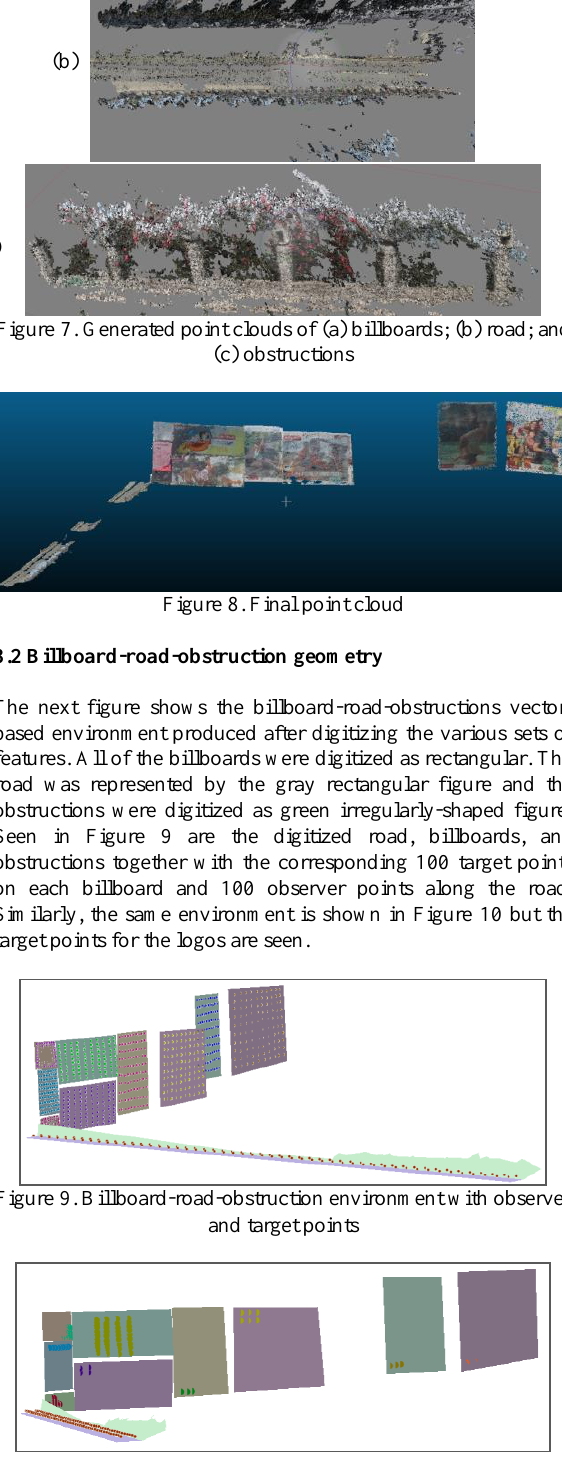
Figure 10. Road and billboards polygons with the varying number of target points on each